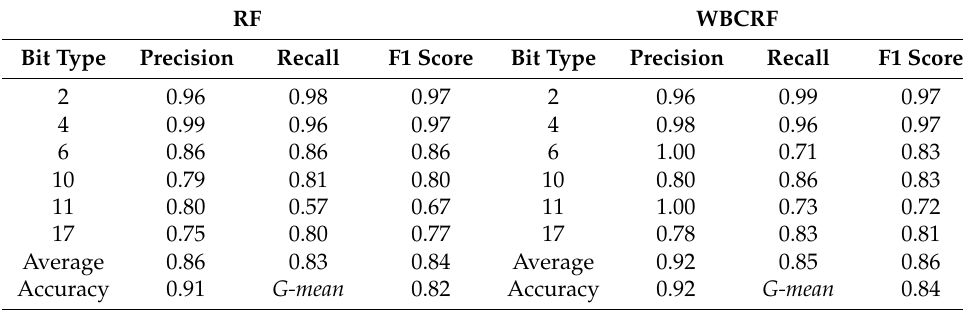
Table 10. The screening of 12.25” bits through RF and WBCRF models. RF WBCRF